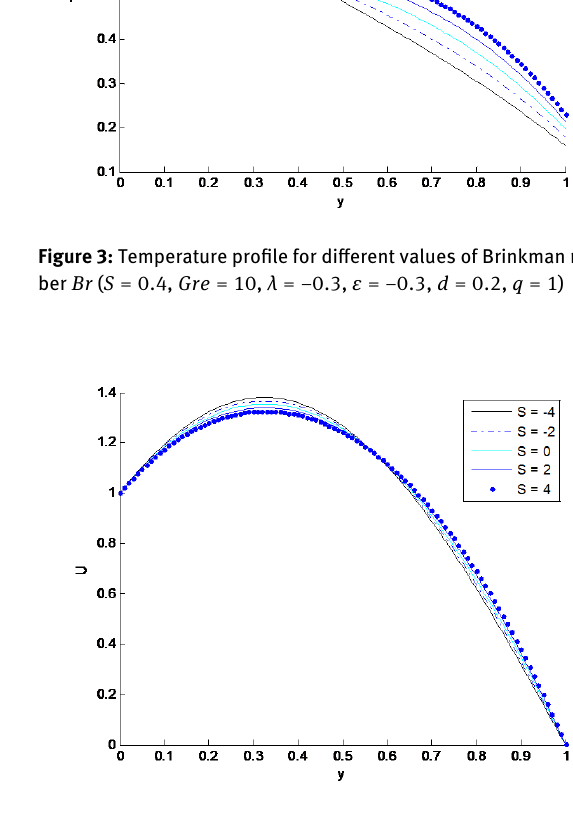
Figure 4: Velocity profile for different values of heat source/sink parameter S ( Br = 0.2 , Gre = 10 , λ = −0.3 , ε = −0.3 , d = 0.2 , q = 1